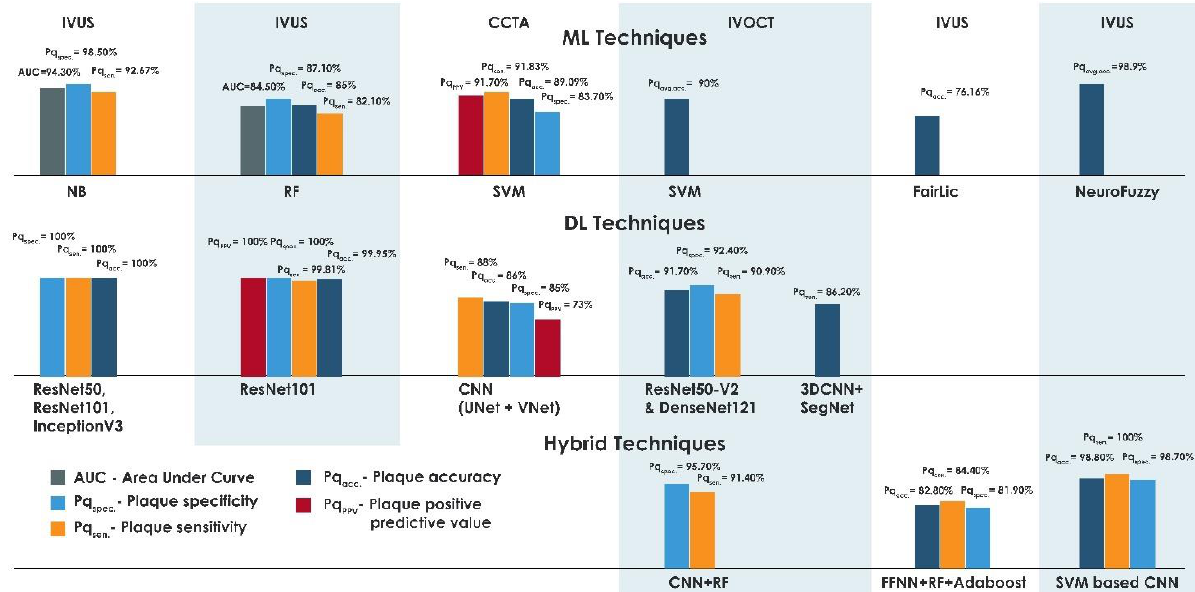
Figure 4. Plot of best-performing techniques with various